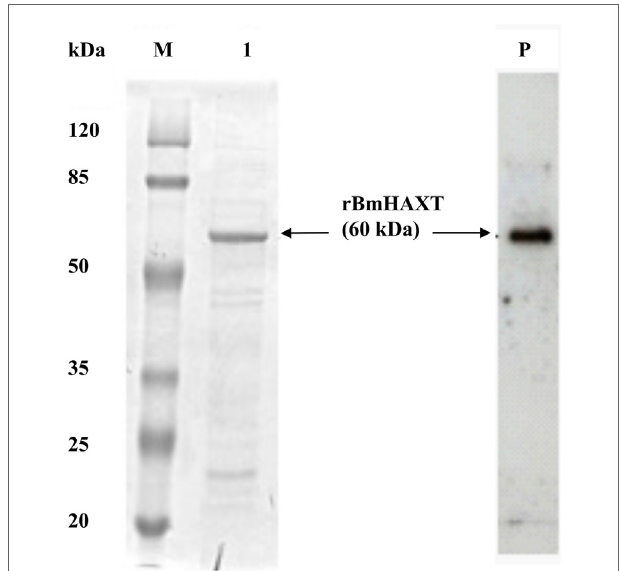
FigUre 1 | Expression of recombinant proteins. Analysis of expressed and purified r Bm HAXT protein was carried out using 12% SDS-PAGE gel. Lanes: M, protein molecular weight marker; 1, r Bm HAXT purified. Lane P: Western blot analysis of purified r Bm HAXT showing 6 × his-tagged